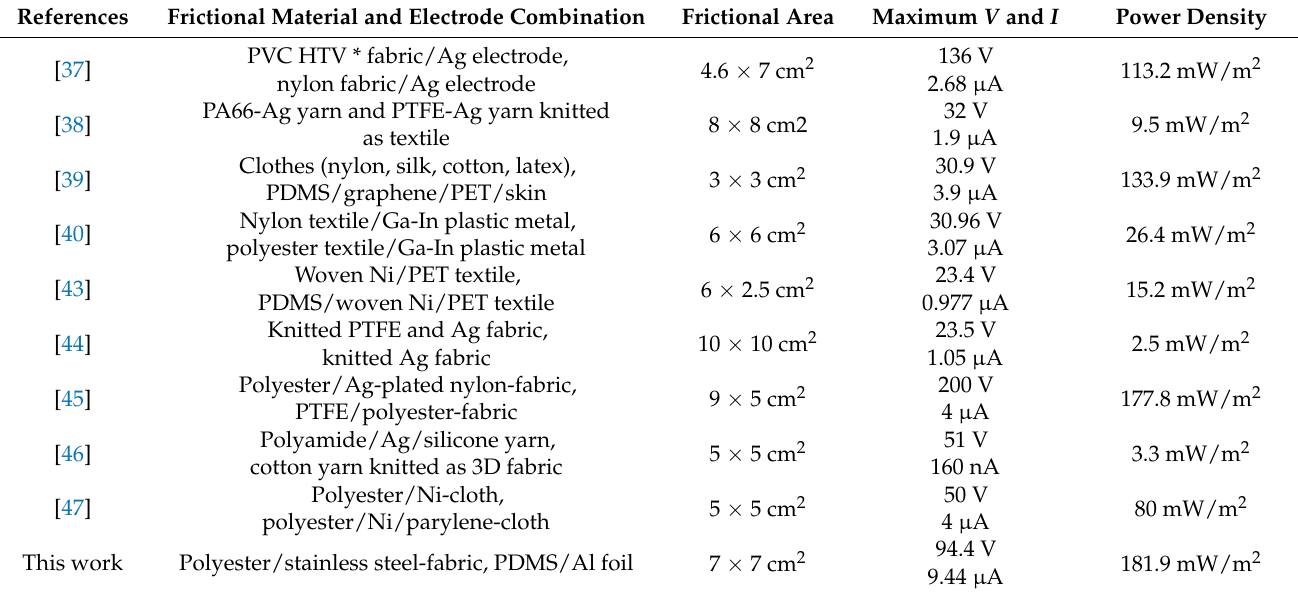
Table 1. Summary of textile-based triboelectric generator performances at different material combinations, contact areas of the frictional surface, and power densities or charge